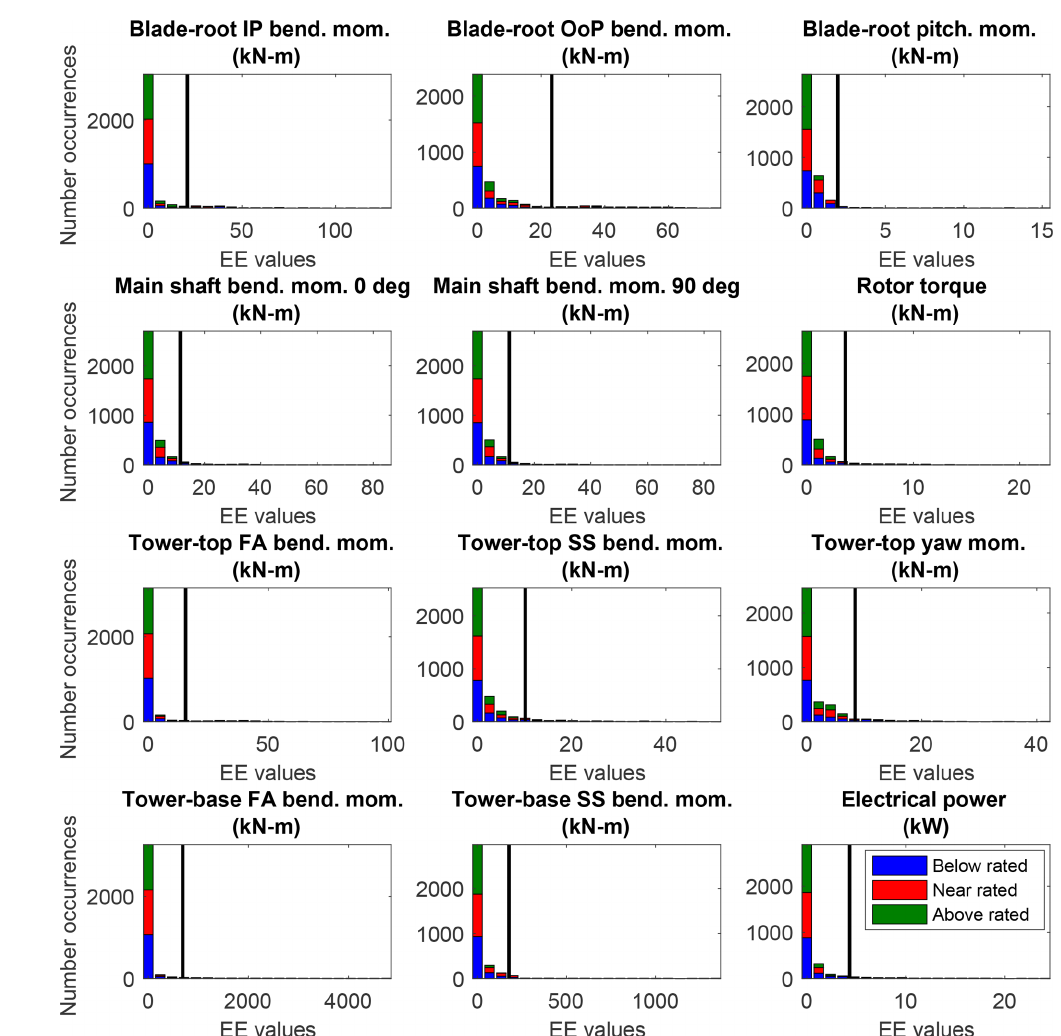
Figure 14. Stacked EE-value histograms of fatigue loads across all wind speed bins, input parameters, and simulation points for all QoIs. The black line represents the threshold by which outliers are counted for each QoI. Color indicates wind speed bin (blue is below-rated speed, red is near-rated speed, green is above-rated speed).